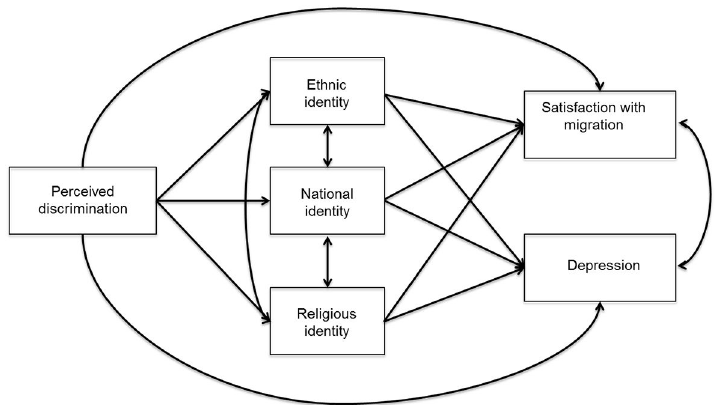
Figure 1. Mediational